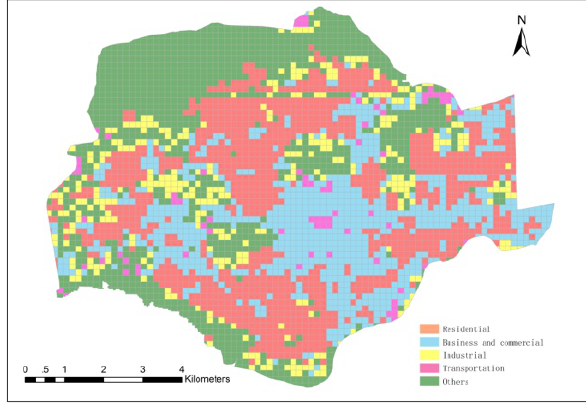
Figure 9. Case study of functional region recognition in Futian